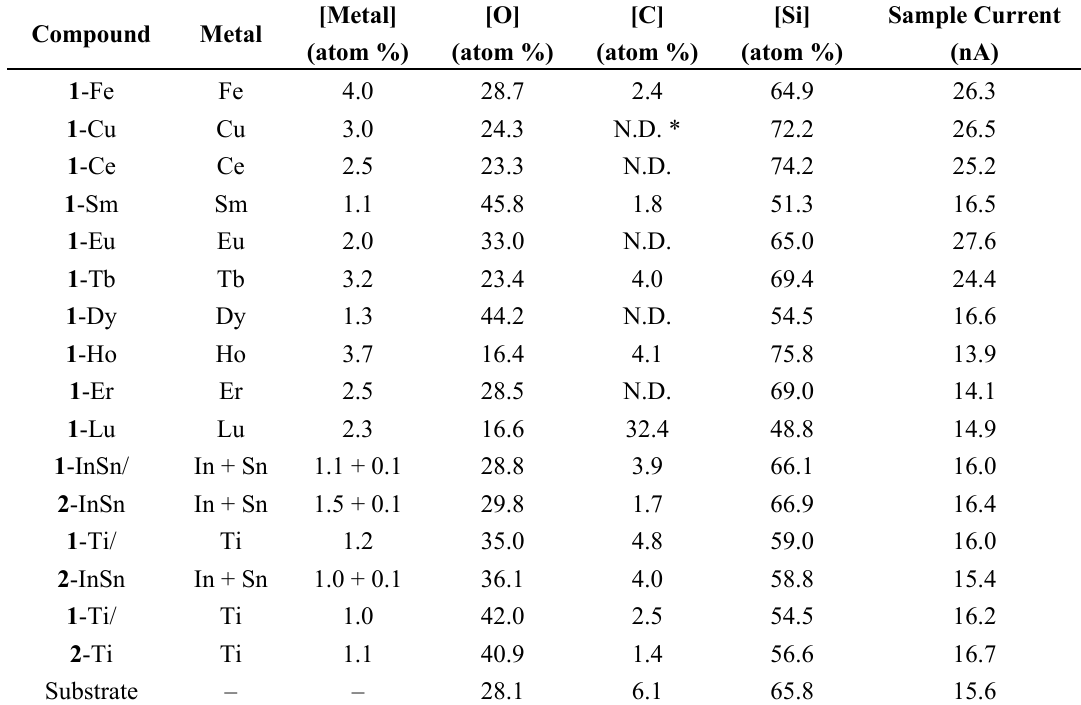
Table 3. EPMA elemental analysis of films formed by pyrolysis of metal complexes at 500 °C in an air